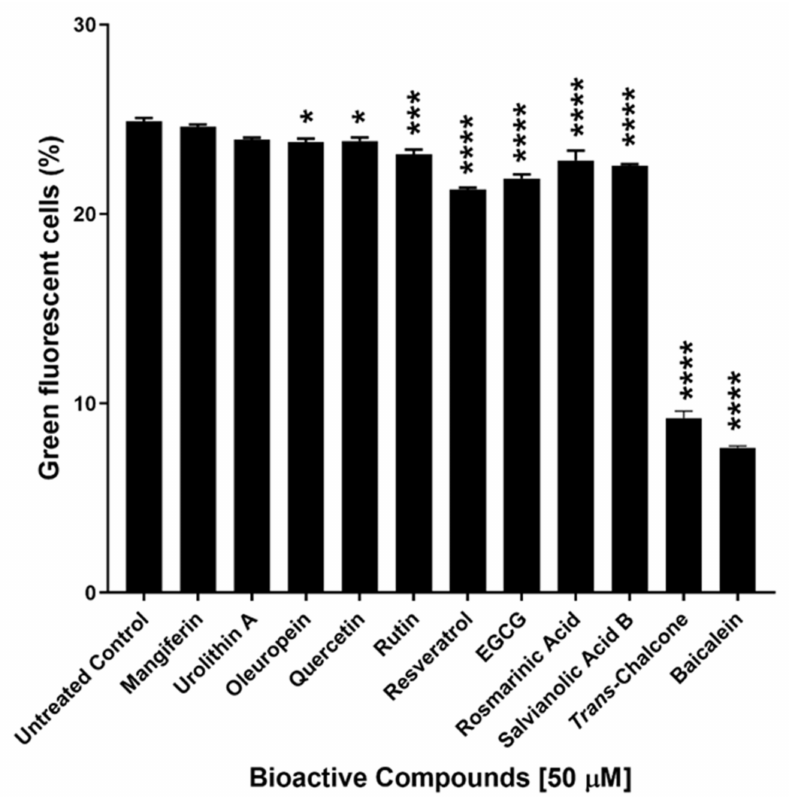
Figure 1. Screening of naturally occurring bioactive compounds by estimating their effects on green fluorescent cells in the population of BY4743 ∆ ahp1 [p416.GPD.GFPA β 42 ] transformants. Statistically significant values obtained from one-way ANOVA with reference to untreated control cells are represented by asterisks (* p < 0.05, *** p < 0.001 and **** p <